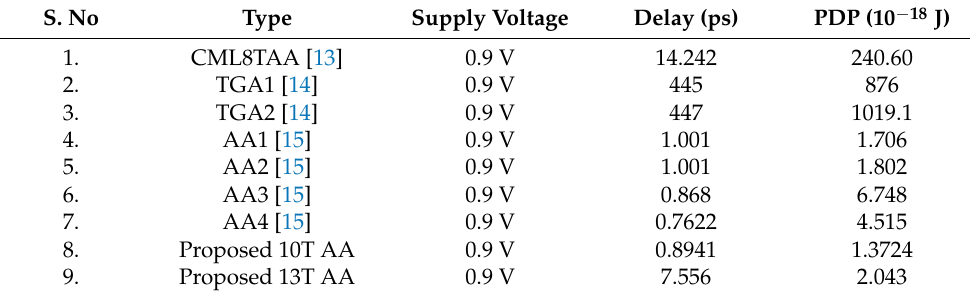
Table 5. Comparison of FA, AA with proposed 10T AA and 13T AA.